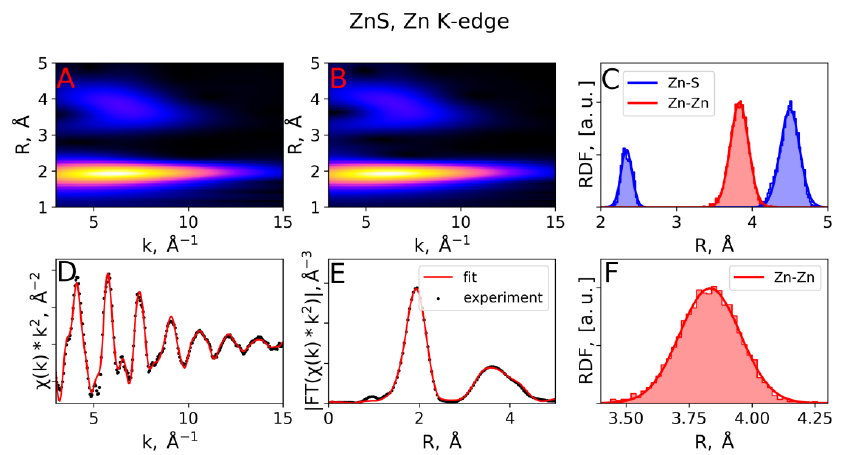
Figure 1. The RMC fit results of ZnS EXAFS spectra. Panel ( A ): experimental WT image; panel ( B ): fitted WT image; panel ( C ): calculated RDF for first three coordination shells around absorbing atom; panel ( D ): experimental (black dotted line) and fitted (red solid line) EXAFS signal χ (k)*k 2 ; panel ( E ): Fourier transform magnitudes of experimental (black dotted line) and fitted (red solid line) χ (k)*k 2 function; panel ( F ): close view of Zn-Zn RDF. The RDFs fitted by Gaussians are shown by solid